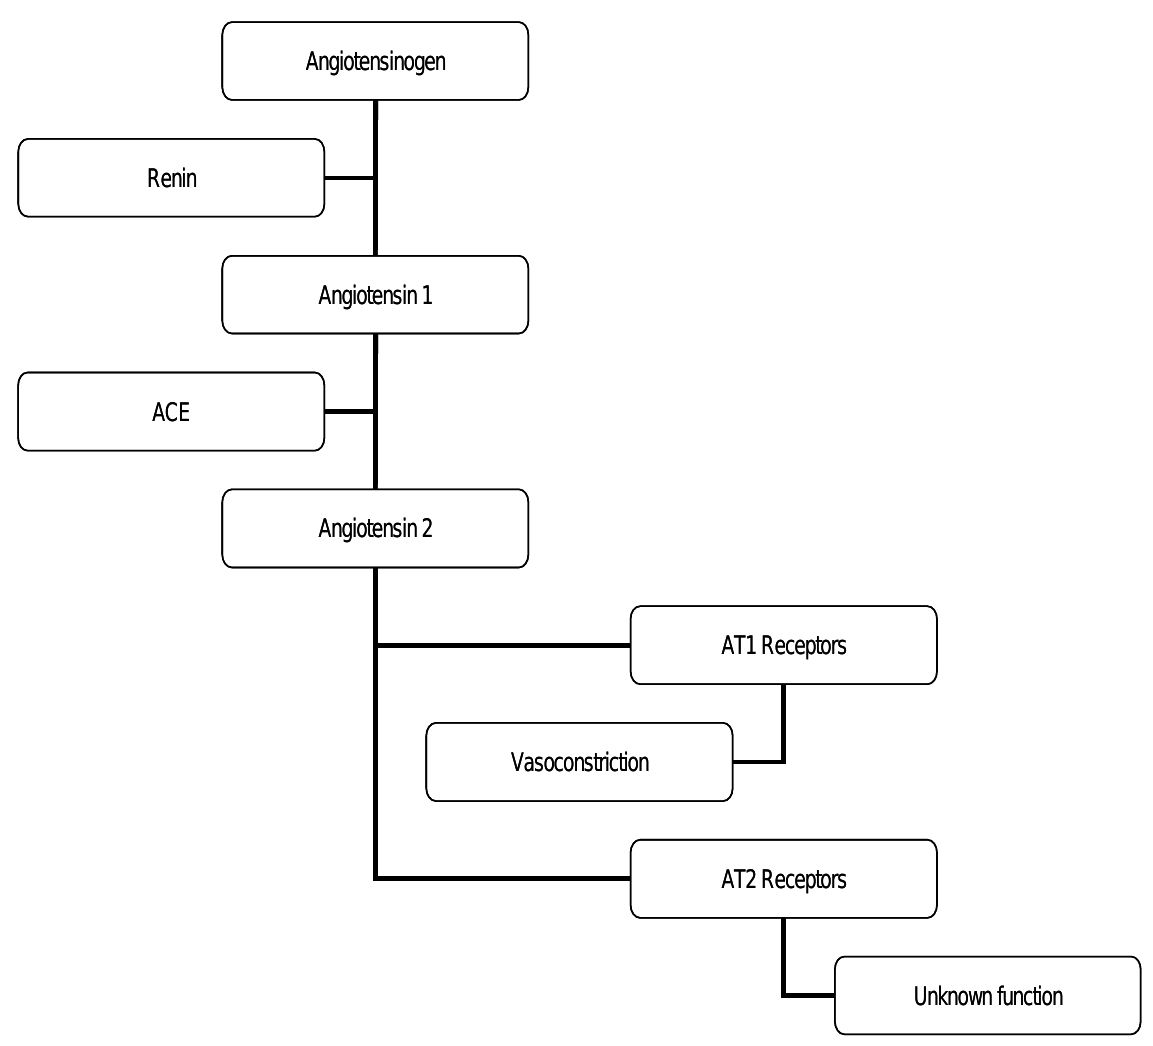
Figure 4. The renin-angiotensin system